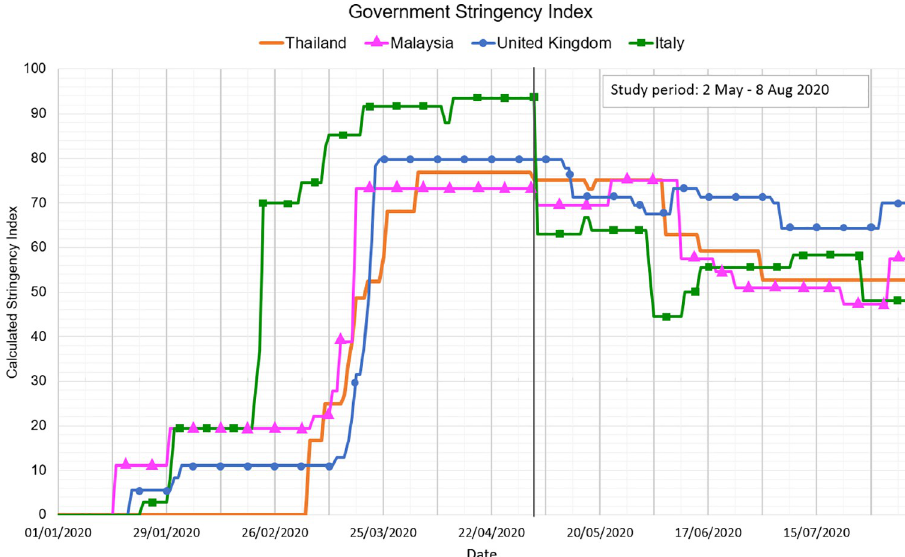
Fig 1. Government stringency index. SI during the first wave of COVID-19 NPIs for Thailand, Malaysia, Italy and the UK.